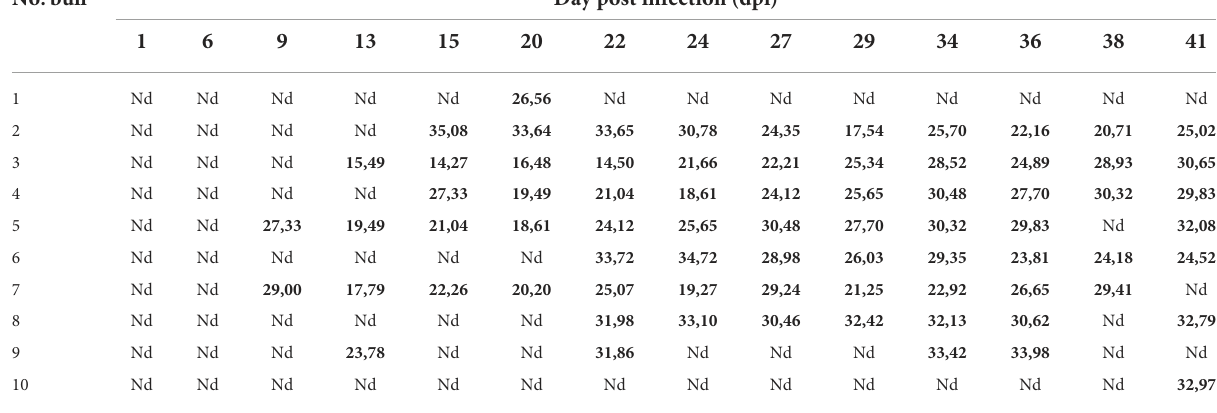
TABLE 3 Real time PCR results detecting the presence of LSDV in nasal swabs (Ct values). No.